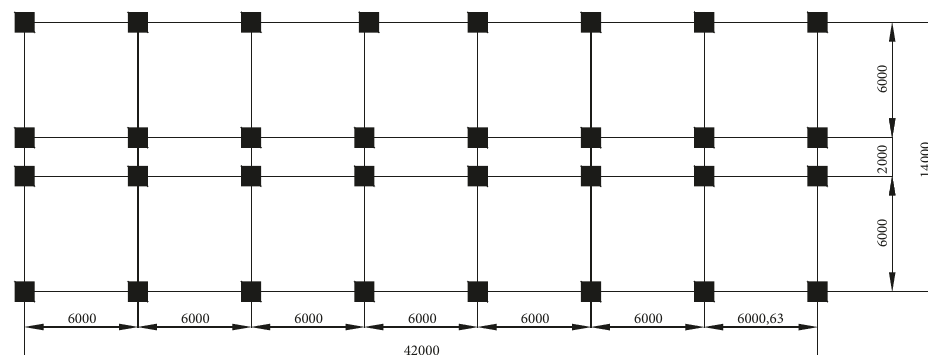
Figure 8: The schematic diagram of building plane (mm).